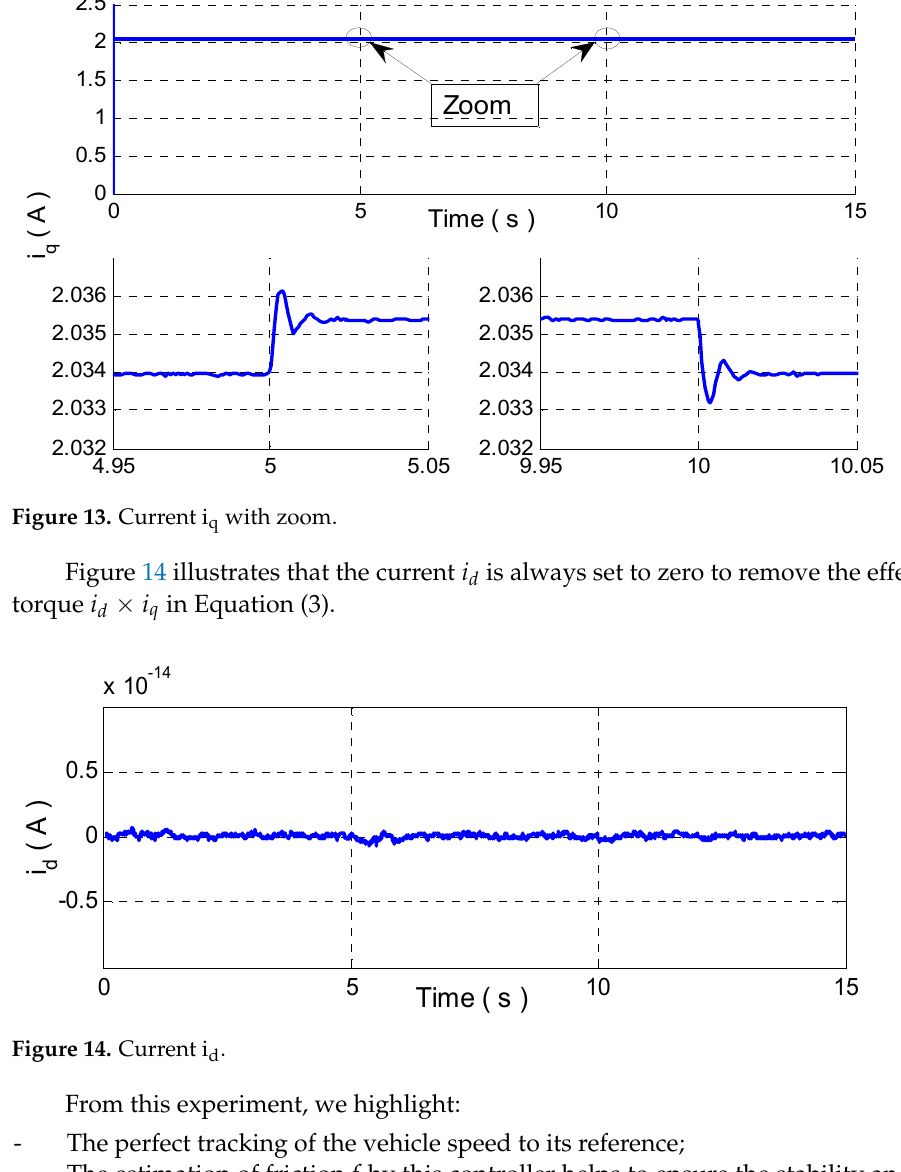
, which leads to an in ‐ (cid:3044)